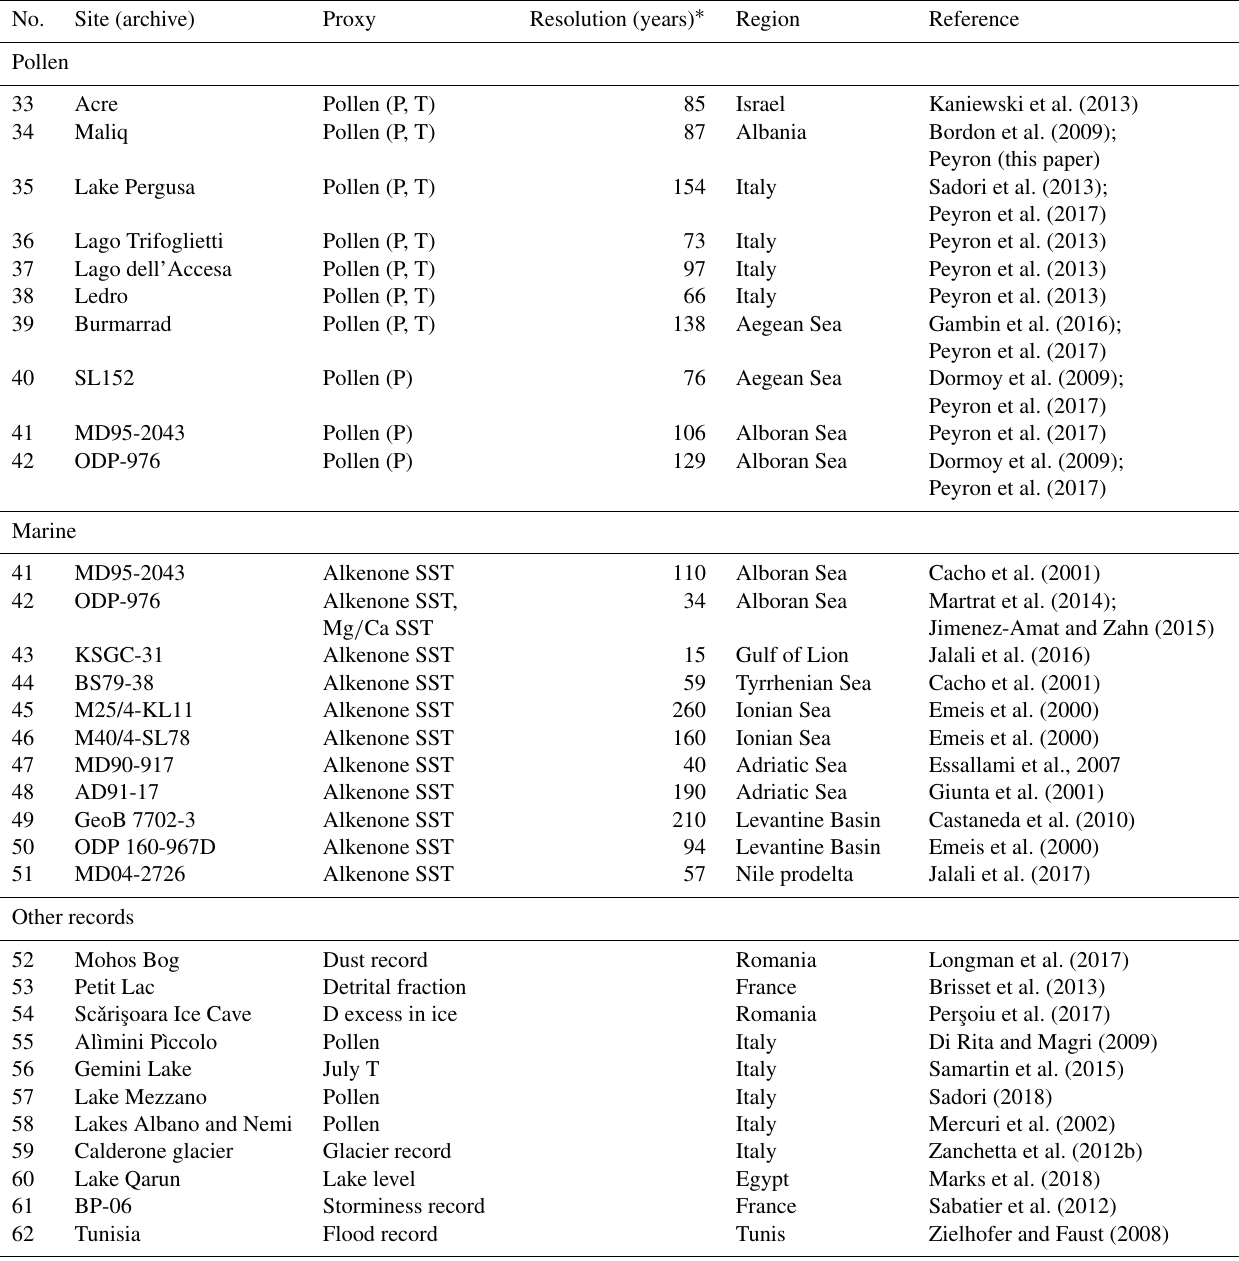
Table 1. Continued. “P” indicates precipitation and “T” indicates temperature.